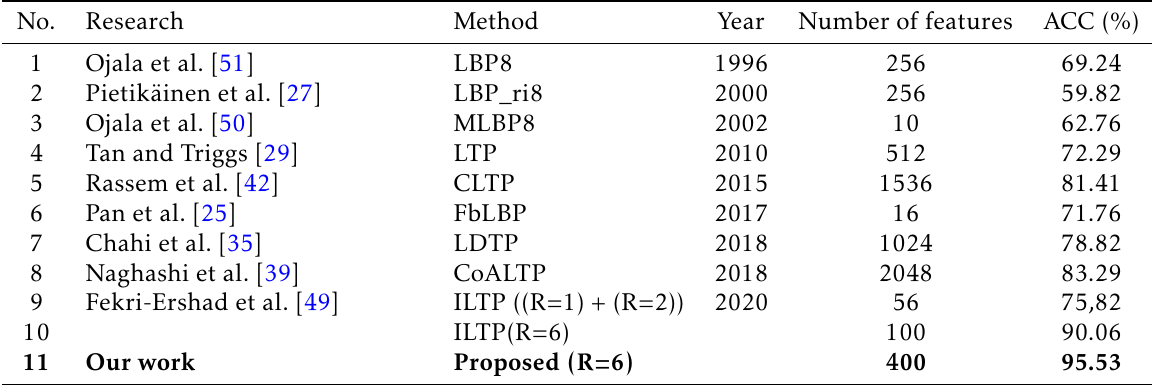
Table 5. Rice varieties classification accuracy from texture descriptors in the literature.